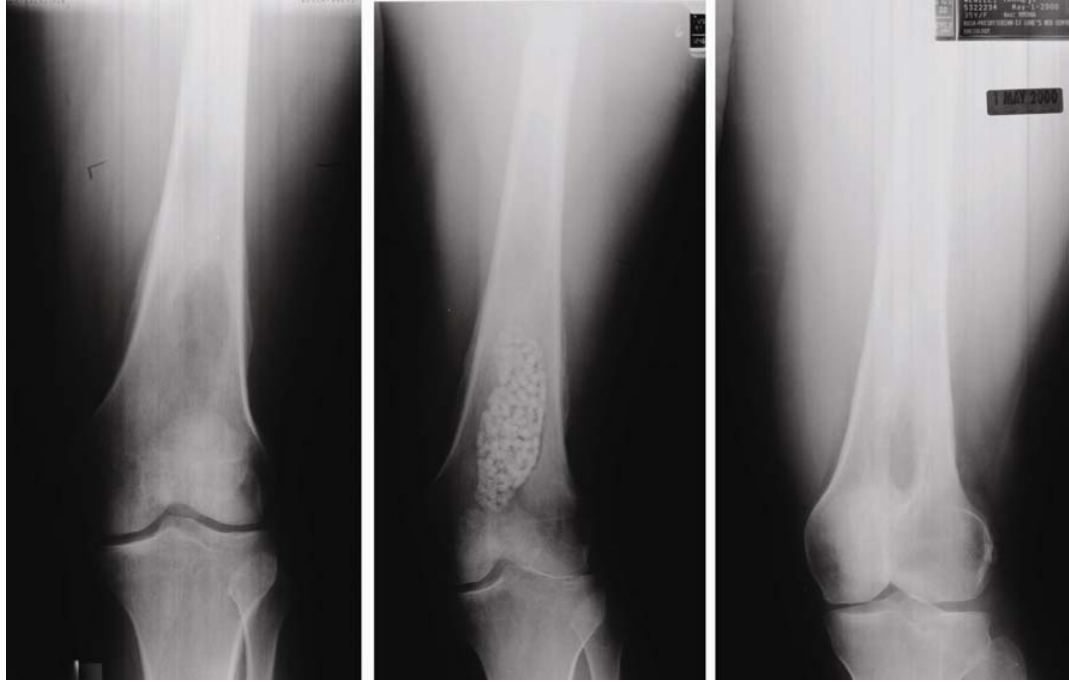
Figure 5. Radiographic assessment of OsteoSet(R) resorbable beads filled into the bone void of a 40-year-old female resulting from osteomyelitis, taken at: preoperation (left), postoperation (middle), and follow-up (right). (Photo courtesy of Wright Medical